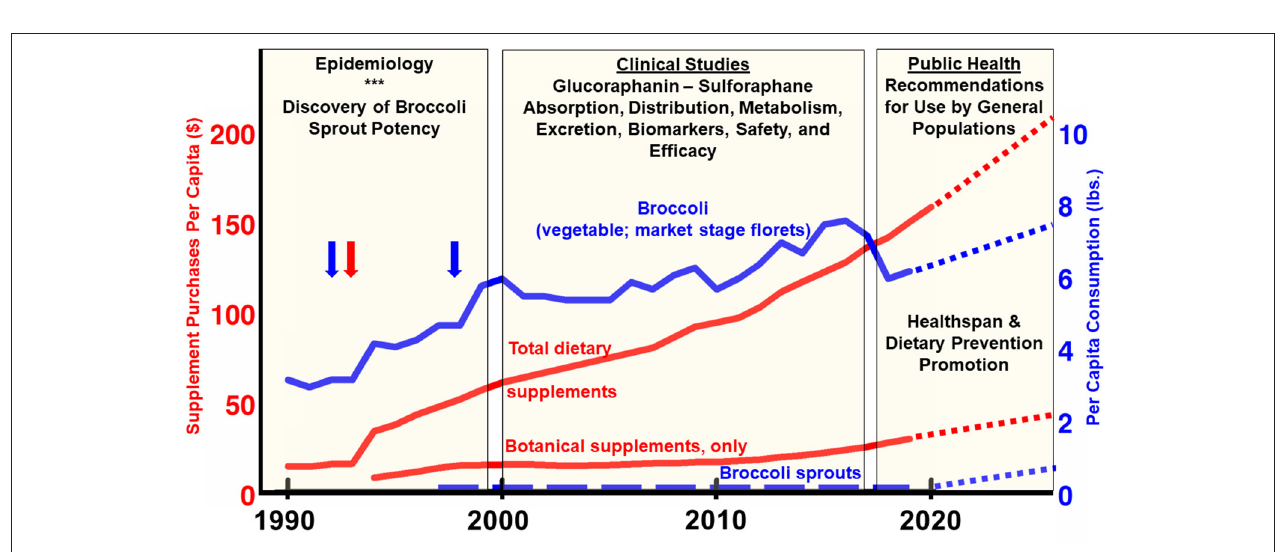
FIGURE 5 | USA consumption per capita between 1990 and 2020. Broccoli per-capita consumption figures reported by USDA Economic Research Service in pounds (blue line; right axis) (103). Blue vertical arrows align with time of first discovery of sulforaphane and description of some of its benefits (3) and of broccoli sprouts (5). The red vertical arrow aligns with the 1994 enactment of DSHEA (the Dietary Supplement and Education Act) which provided a huge stimulus to the supplement industry. Broccoli sprout consumption is imputed, based on our best estimates since no reliable market data exists (dashed blue line; right axis). Since weight-or mass-based metrics would be a meaningless comparison for dietary supplements, total sales (dollar value), and botanical (herbal) supplement sales, are normalized to the US population over the time periods for which data was available (red lines; left axis) (104), and the botanical supplement data break-out came from the American Botanical Council (105, 106). Sales of glucoraphanin, sulforaphane, and broccoli seed- and sprout-rich extracts are a fraction of this magnitude, but no reliable market data exists. All dotted lines for times beyond 2020 are editorial “best guesses”.